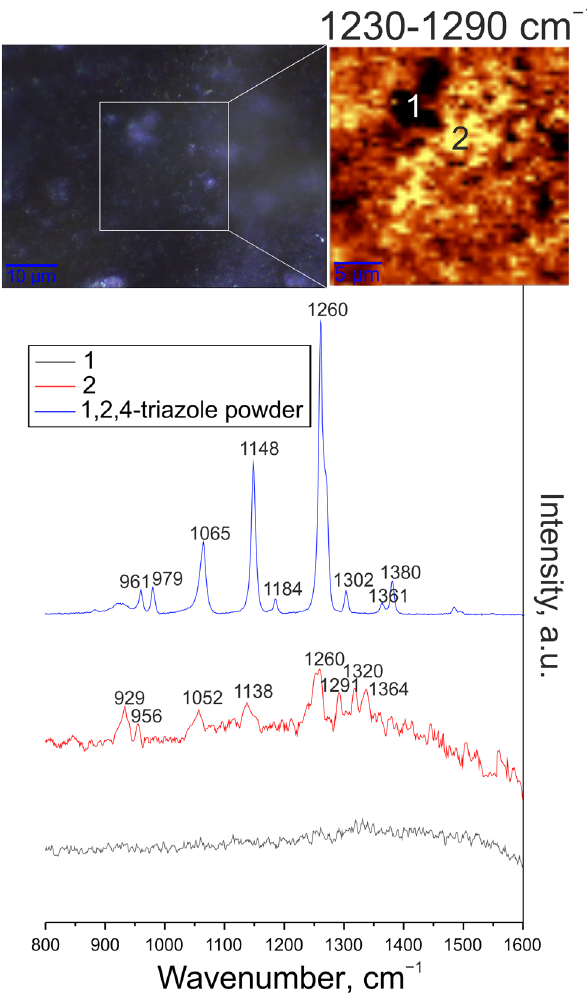
Figure 7. Image of the studied region in the sample, map of the 1,2,4-triazole distribution (2D map was designed using a filter in the spectral range of 1200–1300 cm − 1 corresponding to the characteristic peak for 1,2,4-triazole), Raman spectrum of 1,2,4-triazole powder and Raman spectra of surface areas corresponding to areas of high and low content of the inhibitor.